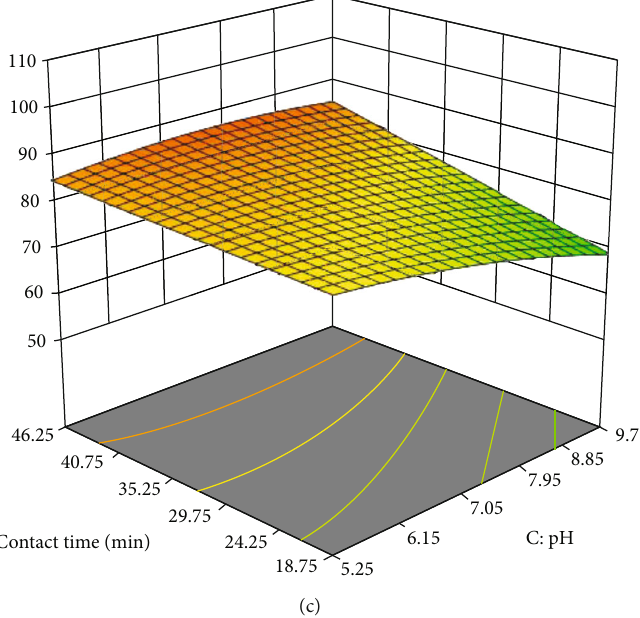
Figure 3: Interaction e ff ects: (a) adsorbent dose versus CIP initial concentration, (b) contact time versus adsorbent dose, and (c) contact time versus